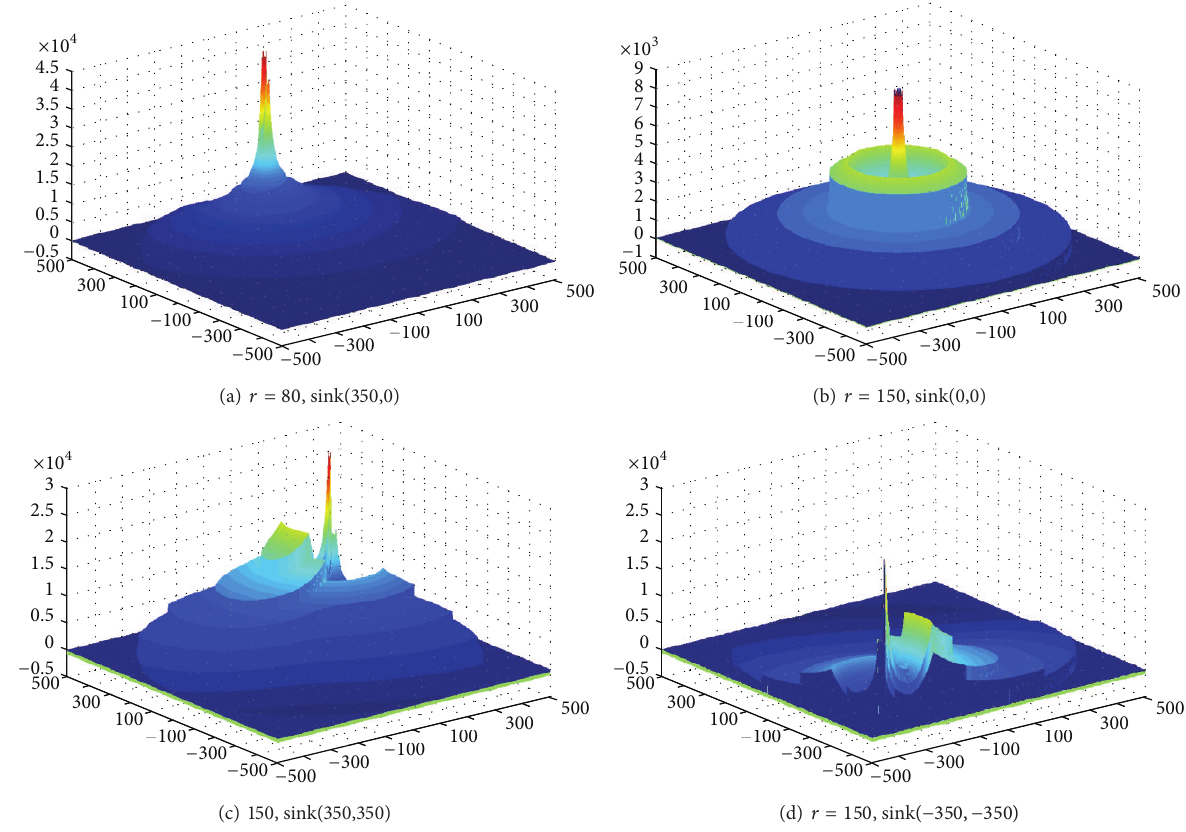
Figure 7: Energy consumption of network ( 𝑅 = 500